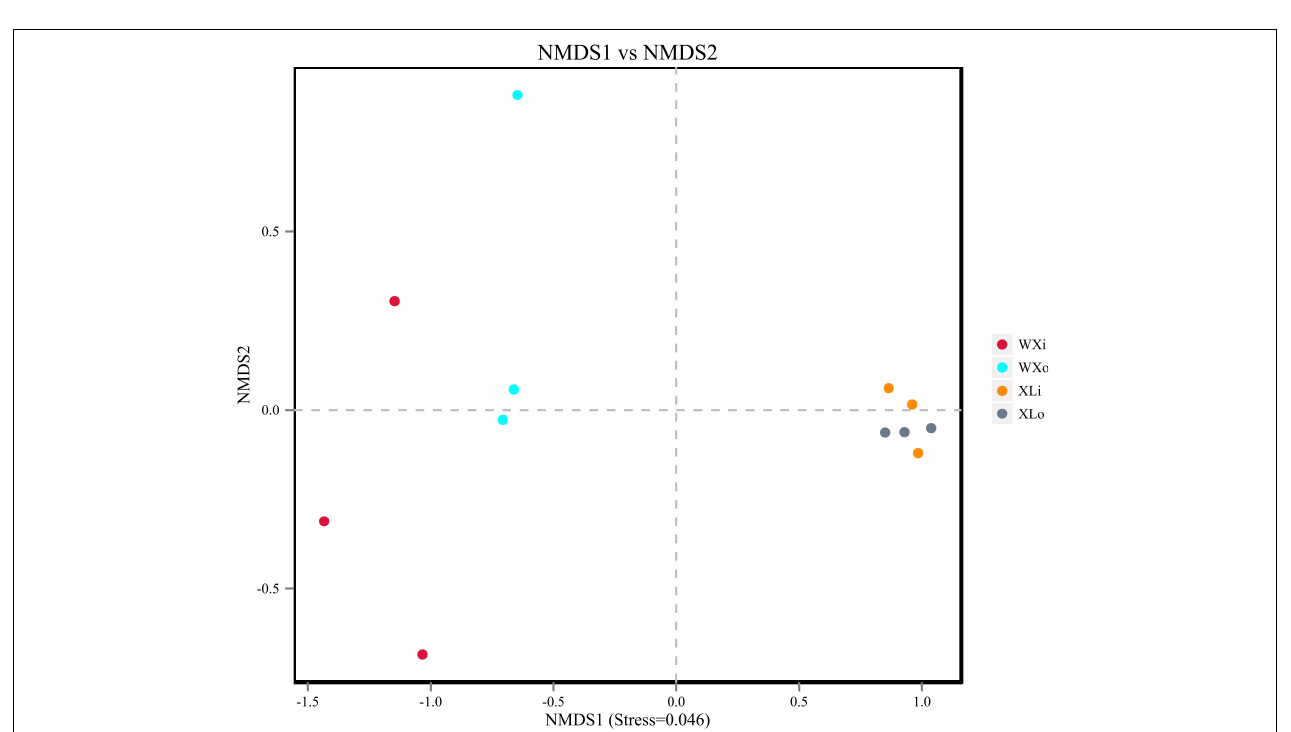
FIGURE 4 | Linear discriminant analysis in microbial community compositions in Doushen samples. The node size represents the difference in relative abundance.